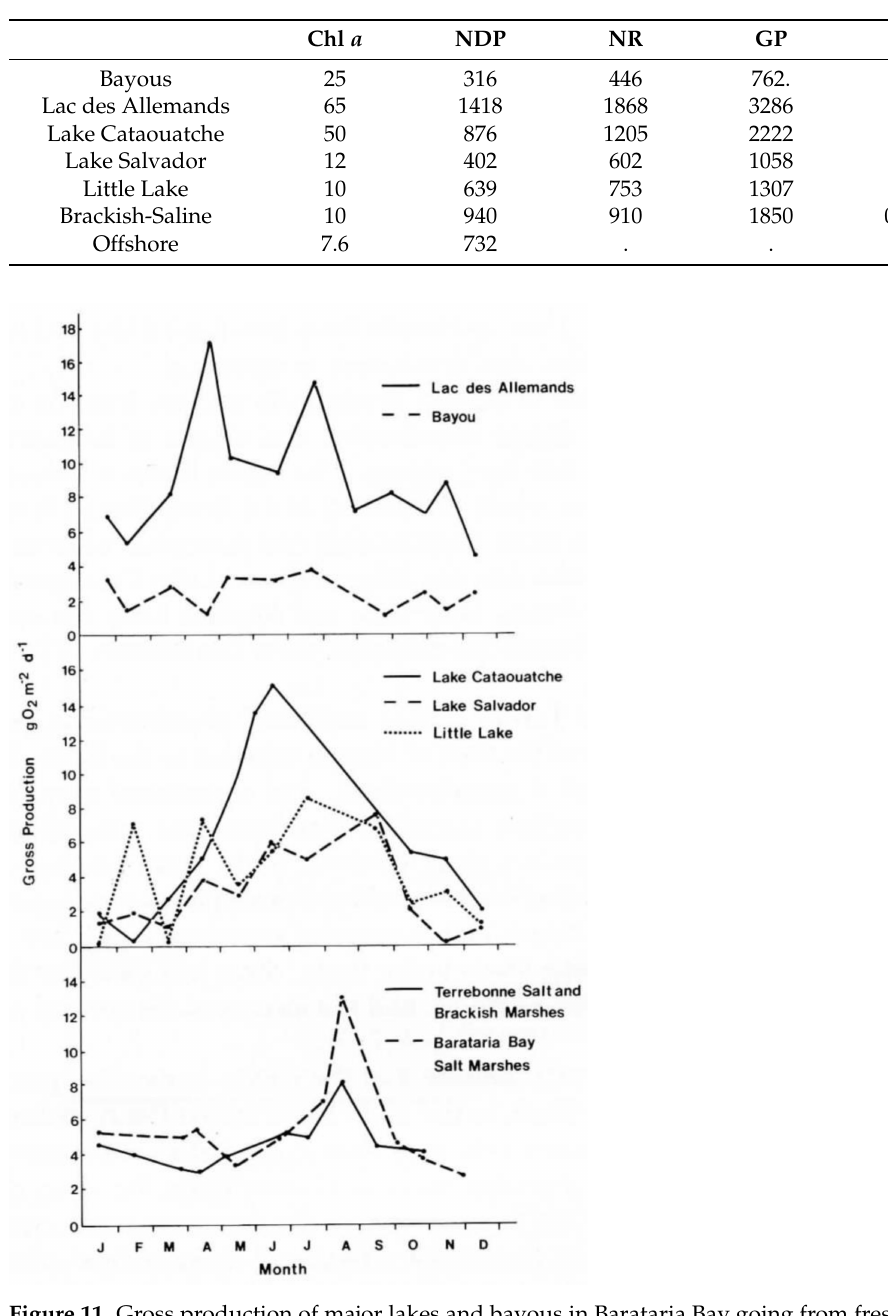
Table 3. Comparative aquatic productivity (g O 2 /m 2 /year) and mean annual chlorophyll a (mg/m 3 ) in Barataria Basin from freshwater bayous to offshore areas. NDP = net daytime photosynthesis; NR = nighttime respiration; GP = gross production; NCP = net community production (modified from [44]; data collected 1973–1981).